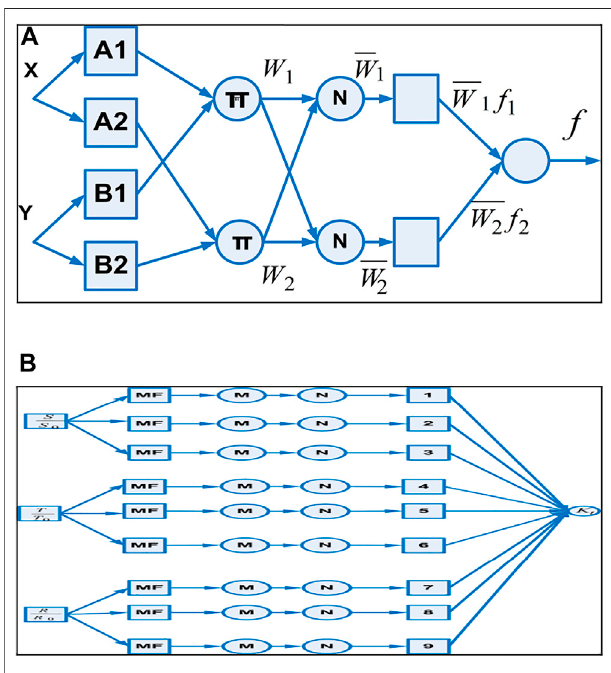
FIGURE 1 | (A) ANFIS structure. (B) Detailed ANFIS structure with three inputs and three membership